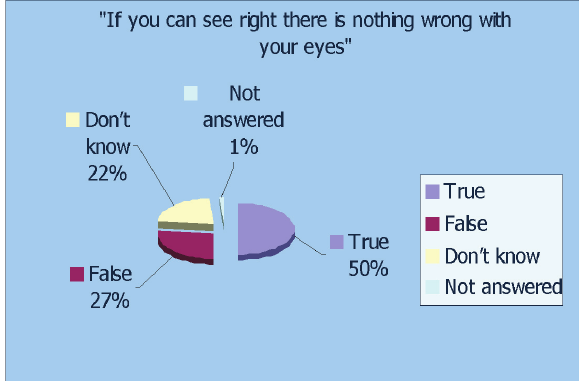
Figure 6 . Patient views of vision and the effects of diabetes on the eye.